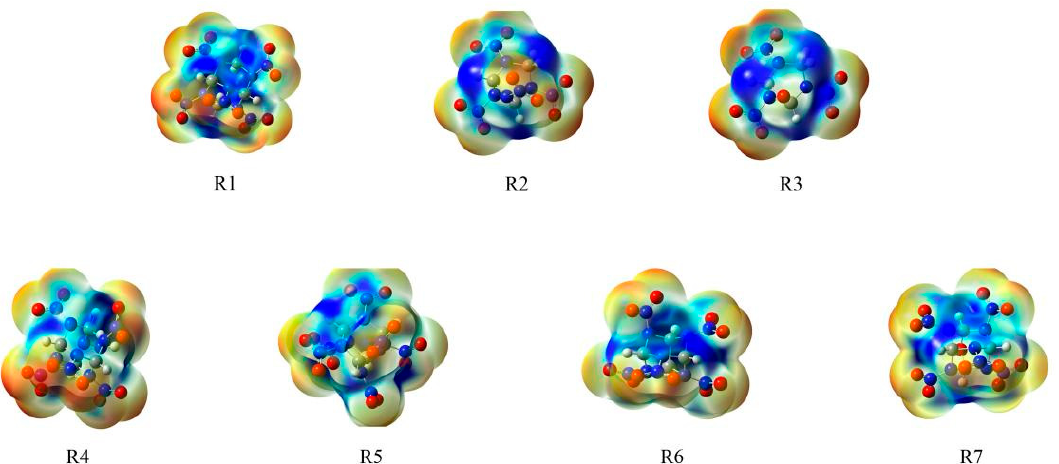
Figure 4. Electrostatic potentials mapped of the designed compounds. Color coding for MEPs range from red (negative) to blue (positive).